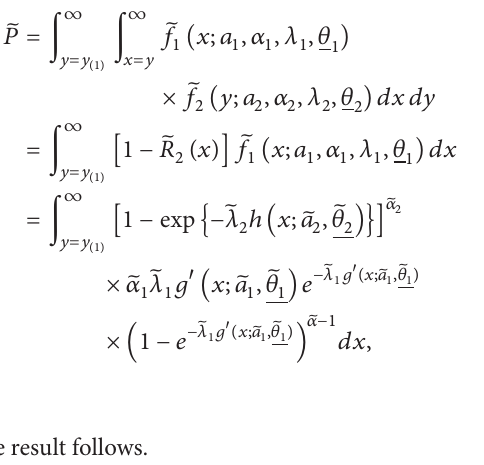
Figure 1: Cures of